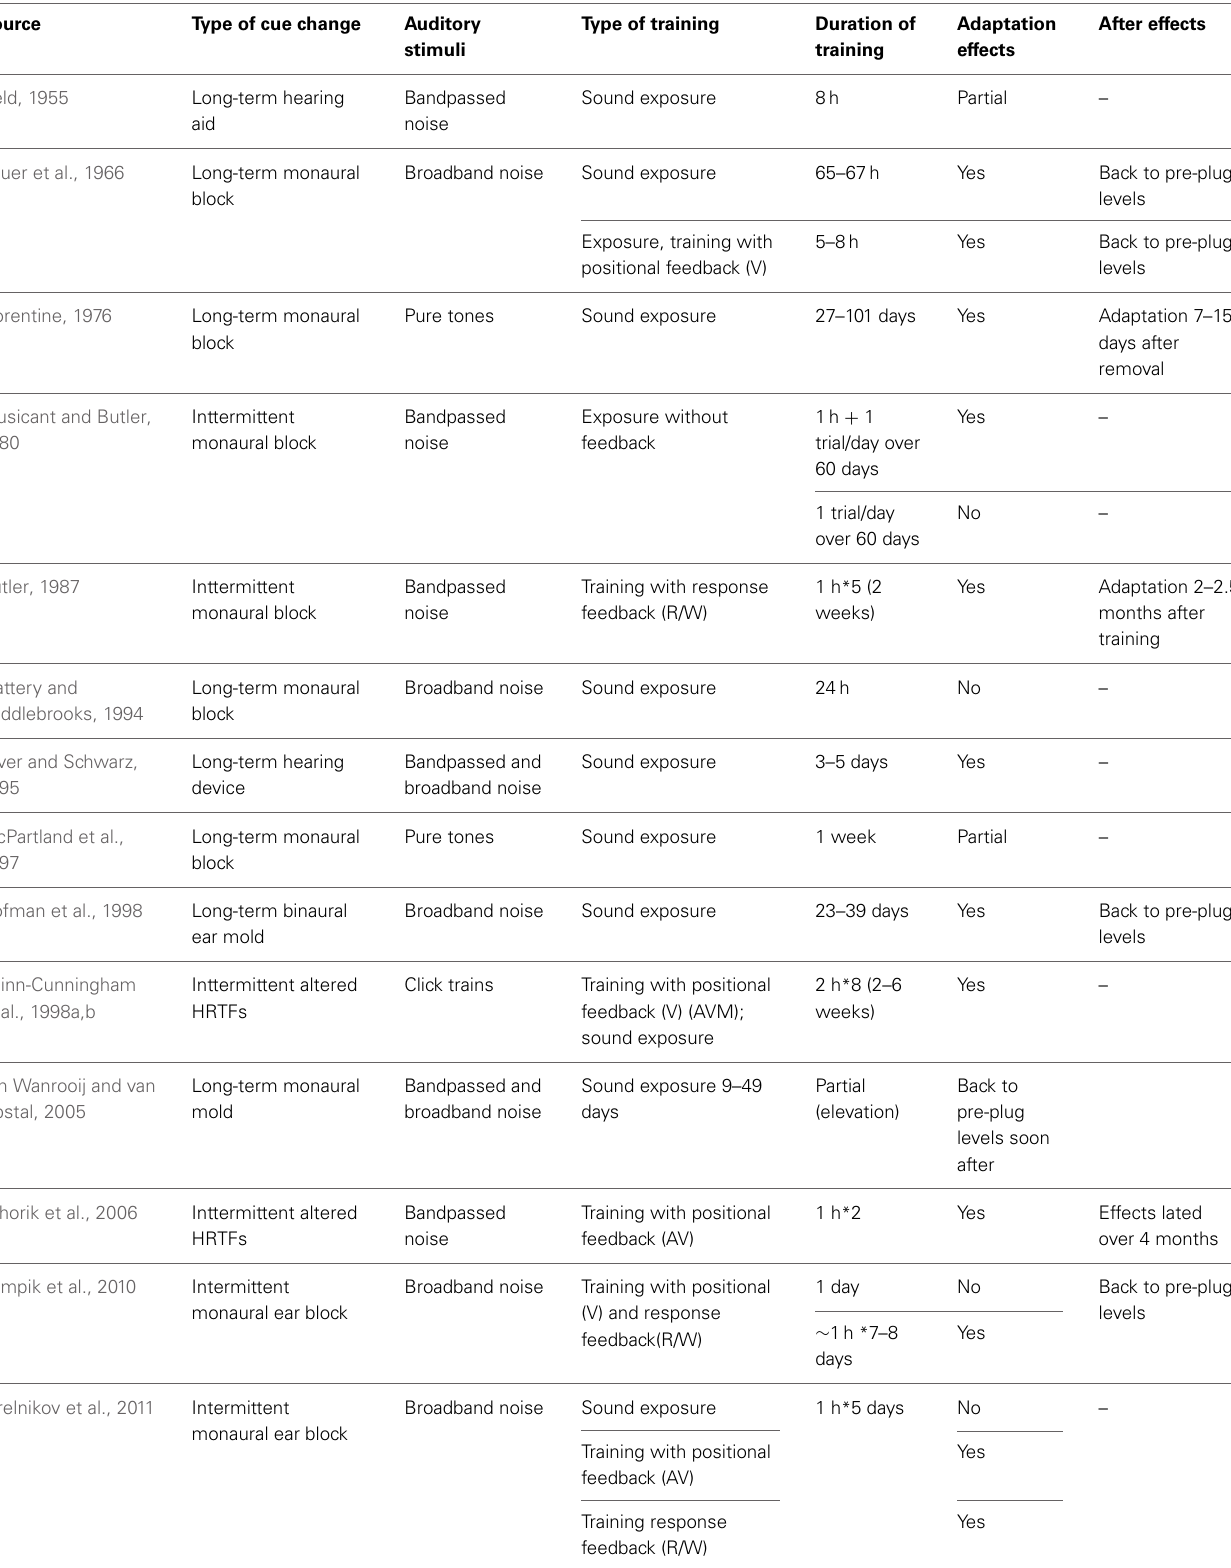
Table 1 | Summary of studies on auditory space adaptation with normal-hearing human listeners.